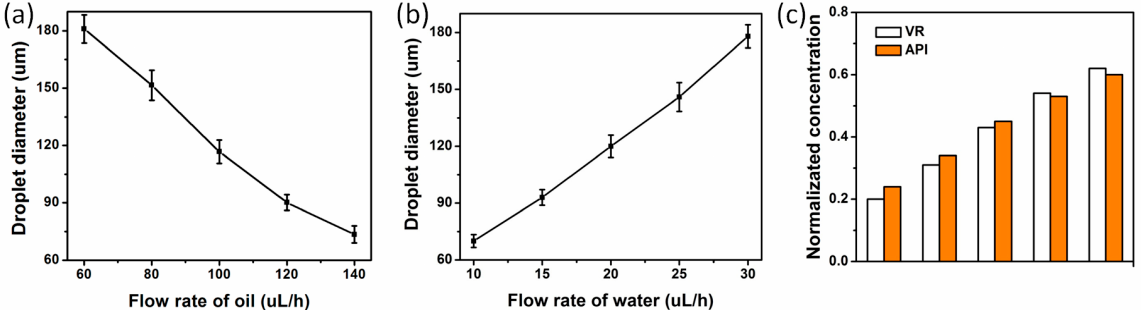
Figure 4. Droplet mean diameters were controlled through ( a ) adjusting the flow rate of oil with the fixed flow rate of dispersed phase solution of 20 μL/h, or ( b ) adjusting the flow rate of dispersed phase solution with the fixed flow rate of oil of 100 μL/h. ( c ) A droplet team with a combination of the concentration gradient of food dye was provided by the desired volumetric ratio (VR) weighed and tested by the absorption percentage of the light (API)